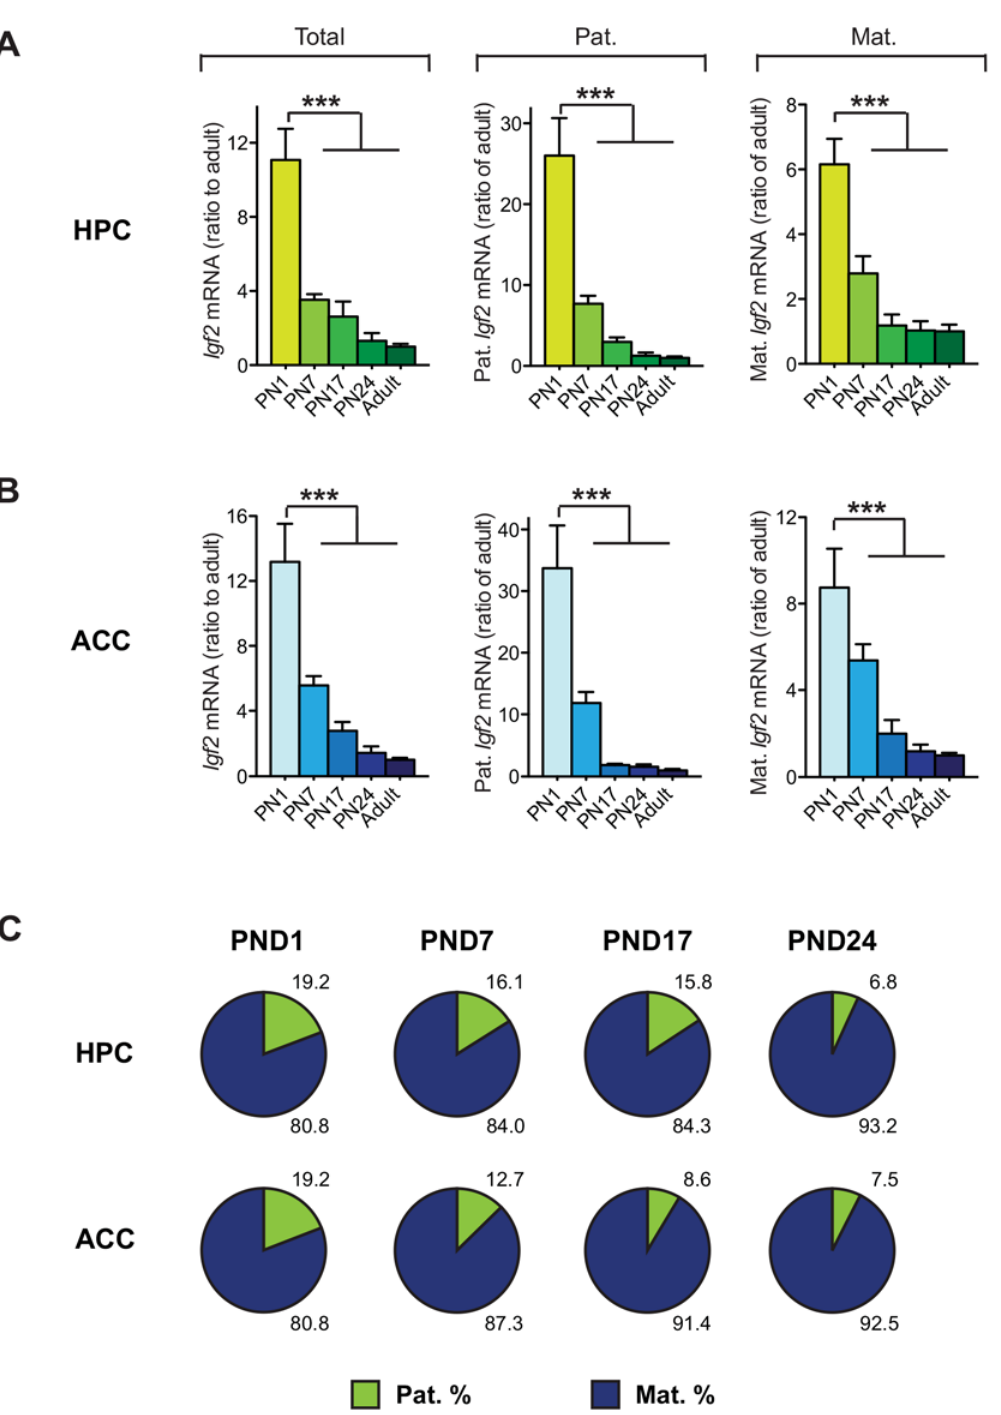
Fig 3. Igf2 mRNA levels in the brain are down-regulated from both paternal and maternal alleles during postnatal development, with a relatively larger decrease of paternal Igf2 . (A-B) Quantitative real-time PCR analysis of total Igf2 level, Igf2 expressed from paternal (Pat.) and maternal (Mat.) alleles, in the hippocampus (HPC; A) and anterior cingulate cortex (ACC; B), collected from postnatal day (PND) 1, 7, 17 and 24 of F1 rats, compared to Igf2 levels of adult HPC (n = 5 – 7; for total Igf2 : F (4, 25) = 23.06, P < 0.0001; for paternal Igf2 : F (4, 25) = 24.42, P < 0.0001; for maternal Igf2 : F (4, 25) = 21.45, P < 0.0001) and ACC (n = 5 – 9; for total Igf2 : F (4, 27) = 22.52, P < 0.0001, P < 0.0001; for paternal Igf2 : F (4, 27) = 21.32, P < 0.0001; for maternal Igf2 : F (4, 27) = 14.75, P < 0.0001). Data analyses combined male and female F1 offspring from both the F (dam) x BN (sire) cross and the reciprocal BN (dam) x F (sire) cross. Igf2 mRNA level in each region was normalized to the 18S RNA level of the same region. Data are represented as mean ± SEM of the ratio of Igf2